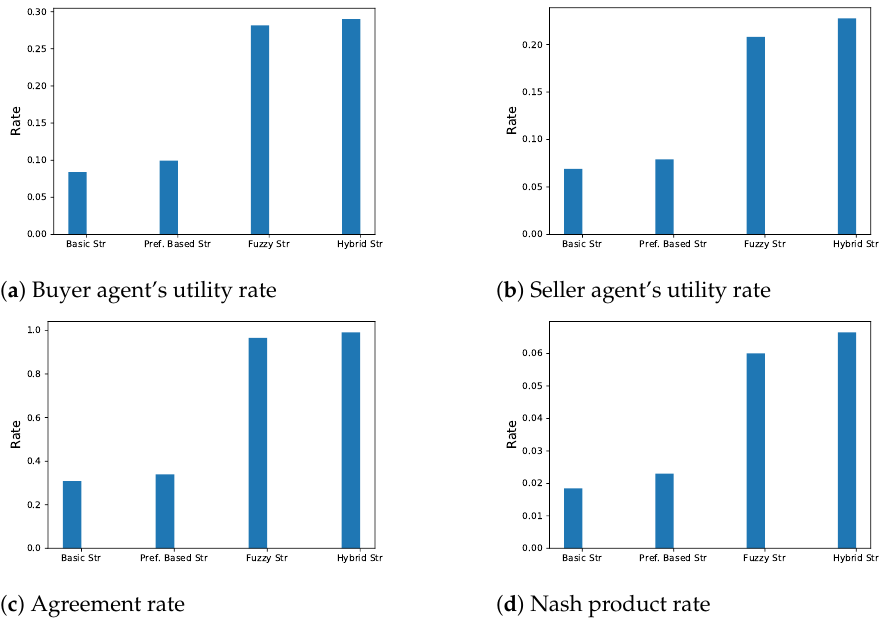
Figure 7. Small overlap and random